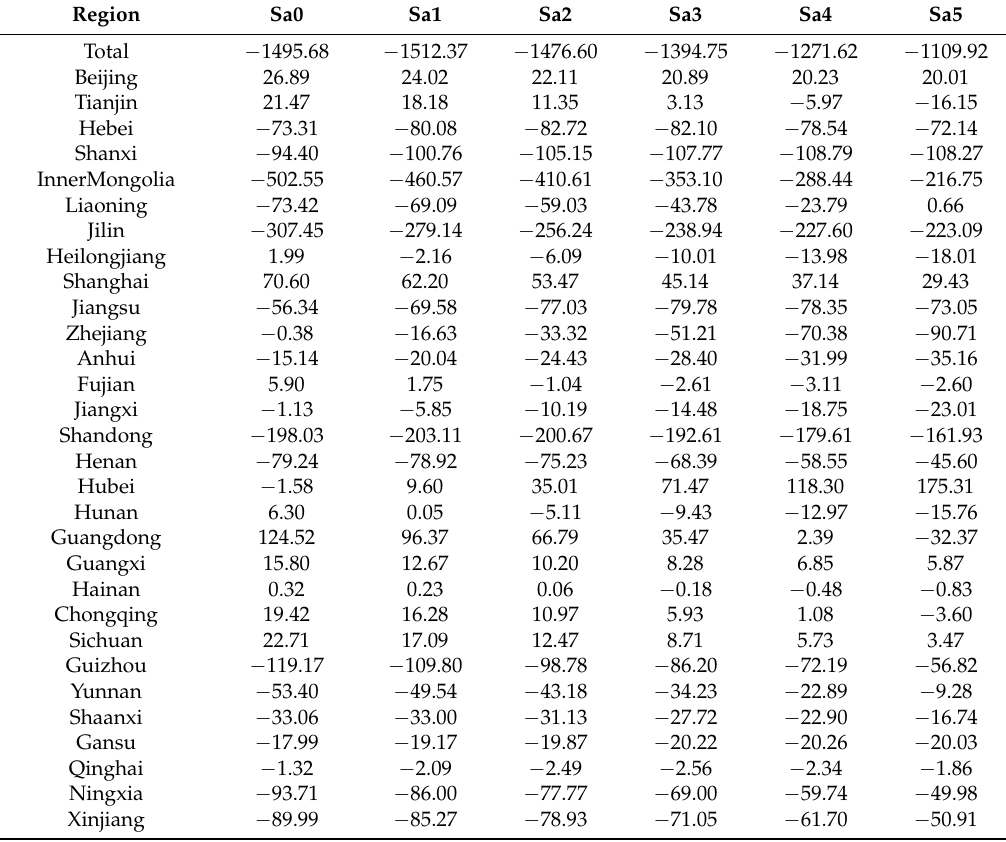
Table 9. Emissions trading volumes of electricity sector in all regions 3 (10 4 ton). Region